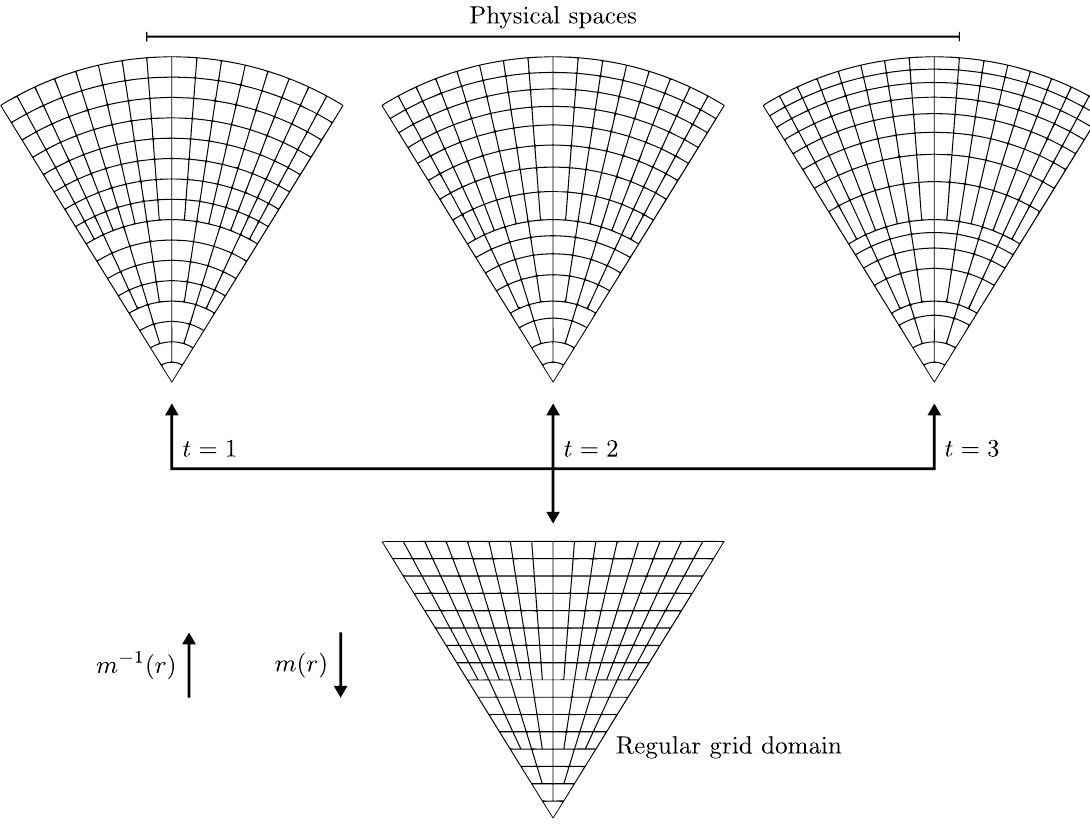
Figure 12. Our three radial mappings applied to the same grid, along with a normalization polyhedral projection. Left: first mapping with linear interpolation. Right: second mapping with cubic interpolation. Middle: third mapping with quadratic interpolation. Note how cells in the right mapping are stretched and squashed in order to preserve their volume better. This effect is also present in the middle mapping, but to a lesser